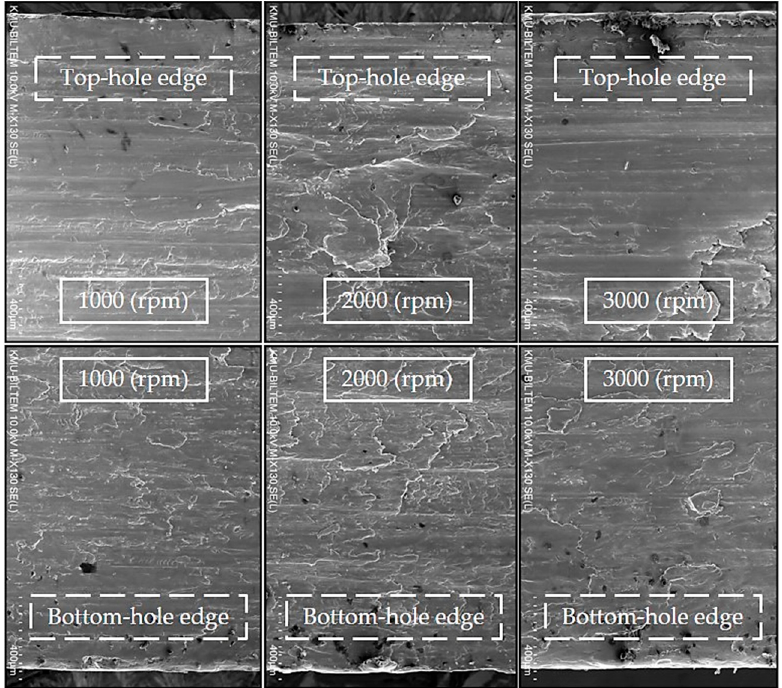
Figure 8. Borehole condition under SEM for holes drilled using 10 mm drills and 0.14 mm/rev.